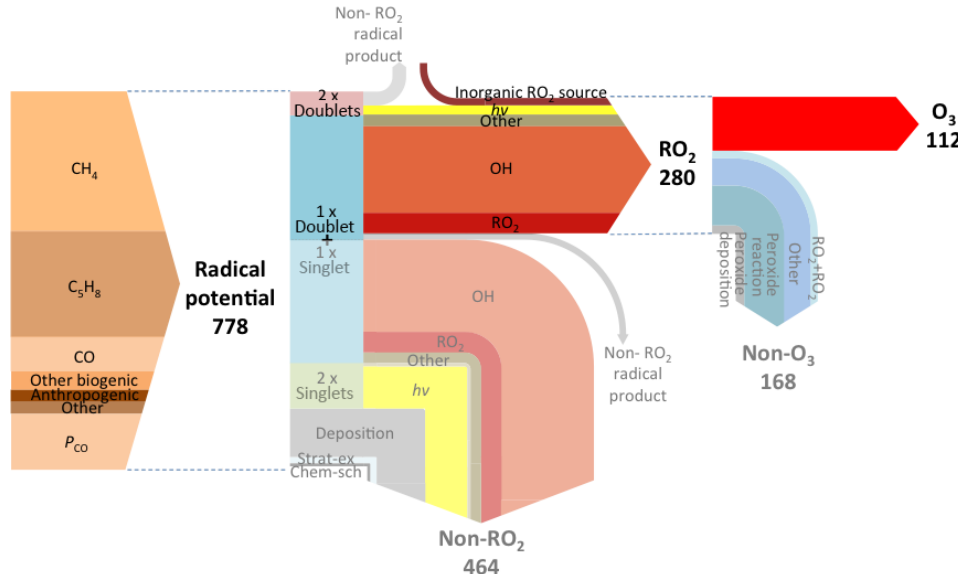
Figure 2. Flow of oxidisable bonds to O 3 production in the GEOS-Chem base simulation. Arrows are coloured according to process, and the arrow thickness is proportional to the flux through that channel. Spin-paired electrons are input as oxidisable bonds into the model (left arrow), with the potential to create 778Tmolyr − 1 of radicals. The actual fate of these bonds is shown in the central arrow, producing 280Tmolyr − 1 of RO 2 , of which 112Tmolyr − 1 reacts with NO to produce O 3 (right arrow).